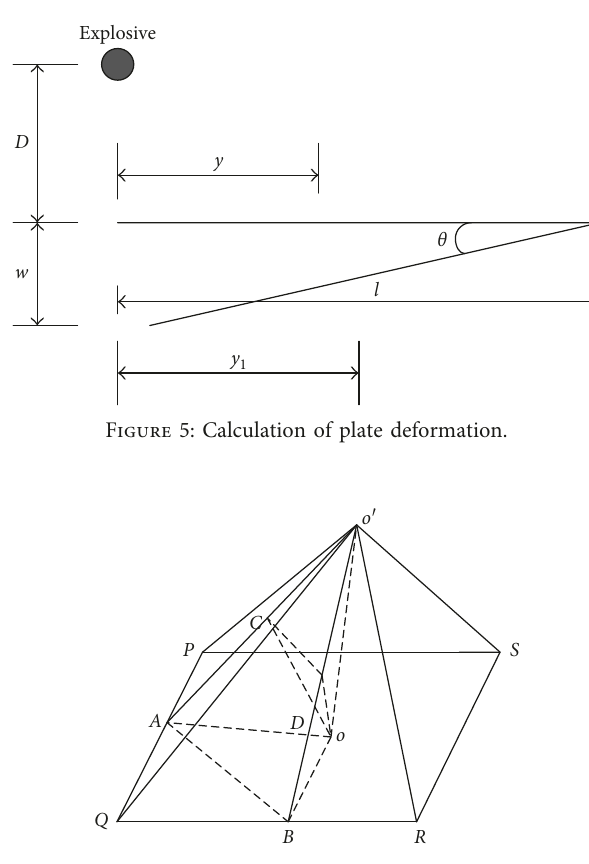
Figure 6: Calculation of the bending strain of the